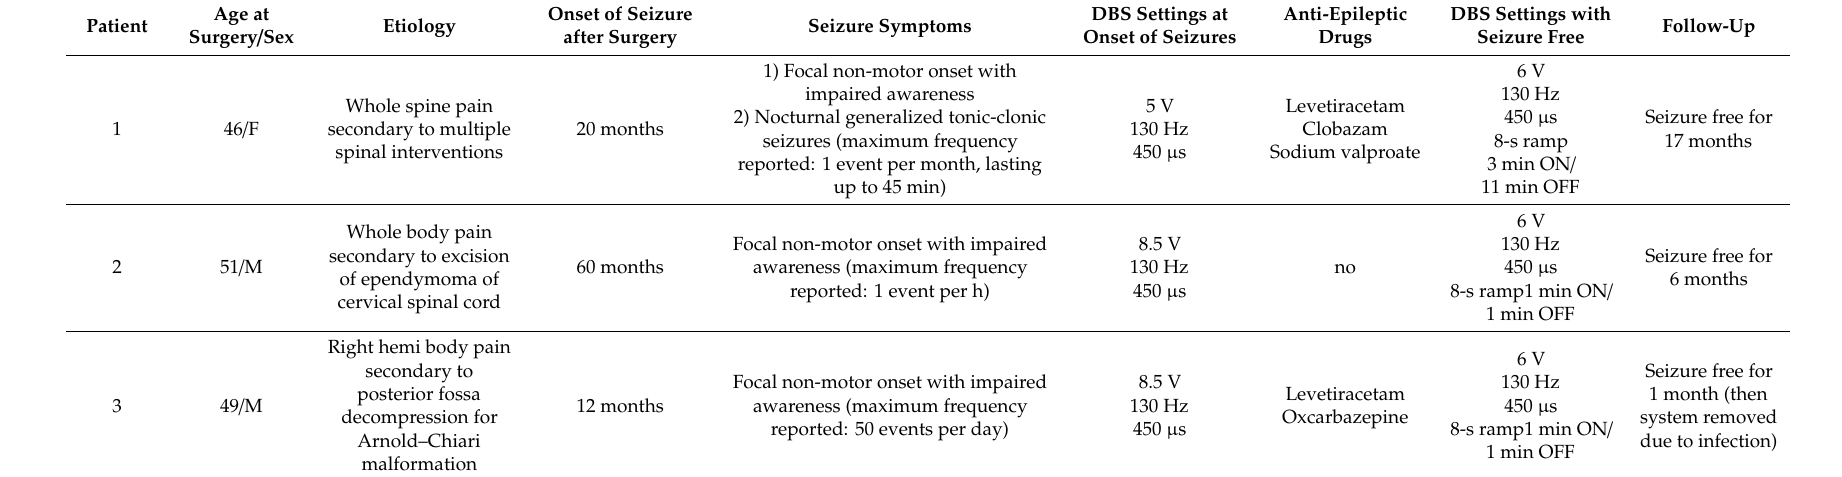
Table 1. Demographics, etiologies, stimulation parameters, and clinical events of